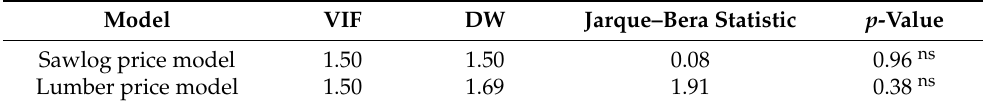
Table 4. Results of econometric classical hypothesis of sawlog and lumber price model. Model VIF DW Jarque–Bera Statistic p -Value Sawlog price model 1.50 1.50 0.08 0.96 ns Lumber price model 1.50 1.69